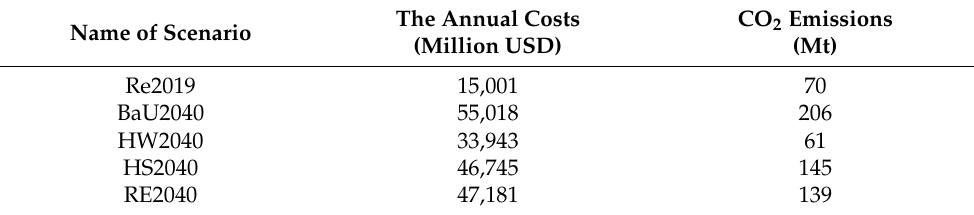
Table 9. The calculated annual costs and CO 2 emissions for different scenarios.